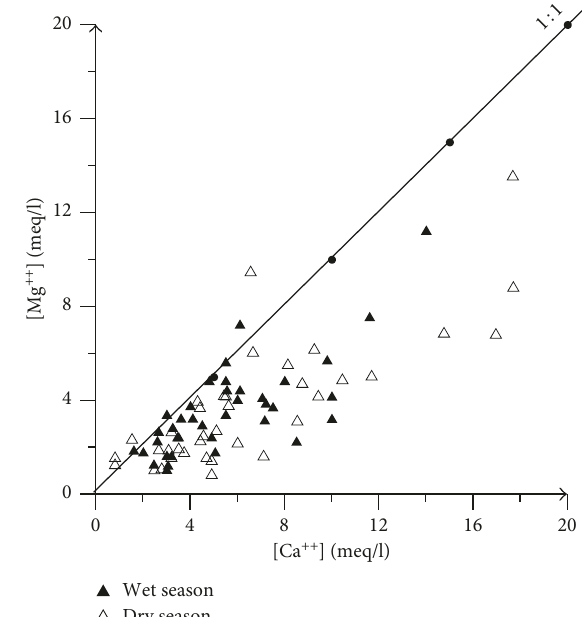
−− ): (a) wet season and (b) dry season. 4